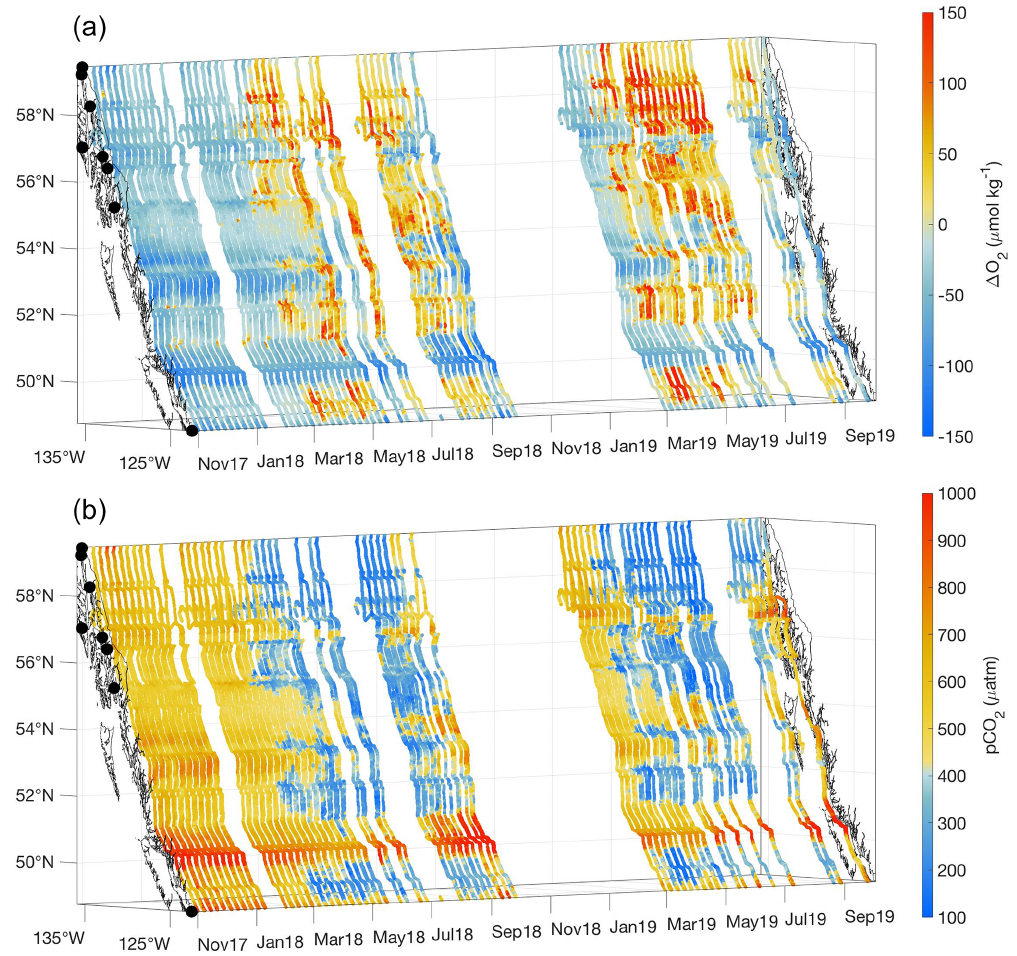
Figure 3. (cid:49) O 2 (µmolkg − 1 ; a ) and p CO 2 (µatm; b ) measured between 3 November 2017 and 2 October 2019. The x and y axes represent longitude and latitude, respectively, and with the coastline and terminal positions shown as in Fig. 1 and time increasing along the z